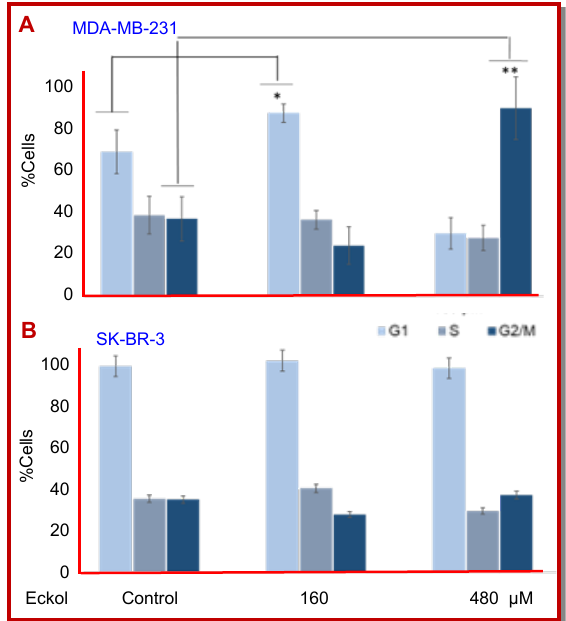
Figure 5: Eckol treatment after 2 hours cell cycle analysis. MDA-MB-231 cells were exposed to 160 and 480 µM eckol for 2 hours for determinization of the cell cycle phase (A). SK-BR-3 cells were treated with 160 and 480 µM eckol for 2 hours for determinization of the cell cycle phase (B). a indicates p<0.05, b p<0.01, c